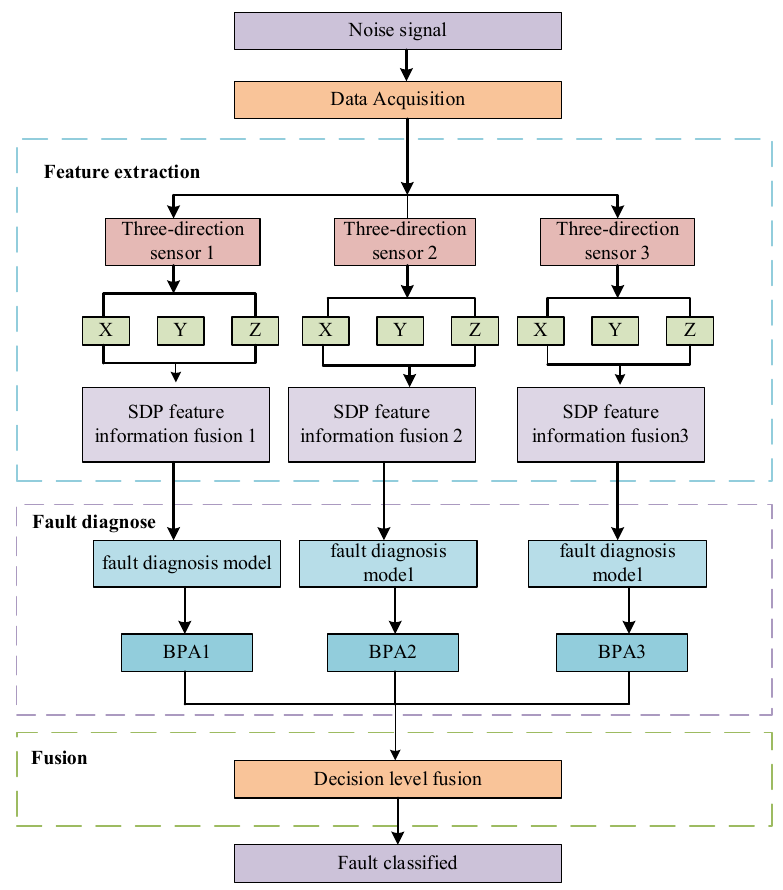
Figure 15. Fault diagnosis framework based on multi-channel gear pitting level.